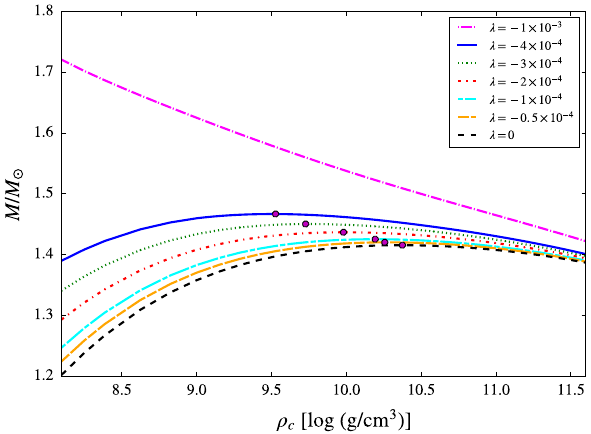
Fig. 4 The dependence of the total mass of the white dwarfs on central density for different values of